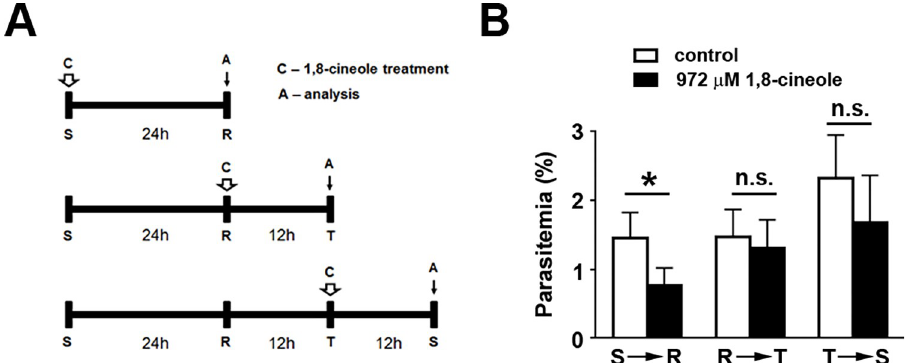
Fig 2. Assessment of the effect of 1,8-cineole on specific stages of the P . falciparum life cycle and evolution. (A) Experimental design. Different evolutive forms of P . falciparum were treated with 972 μ M 1,8-cineole, and parasitemia was determined by optical microscopy (analysis). The arrows indicate when treatment with 1,8-cineole started. S, schizonts; R, rings; T, trophozoites. (B) Determination of parasitemia right after differentiation ( n = 5). S ! R, evolution from schizont to ring; R ! T, evolution from ring to trophozoite; T ! S, evolution from trophozoite to schizont. The results are presented as the mean ± SD. � P < 0.05 versus control. n.s., not significant.